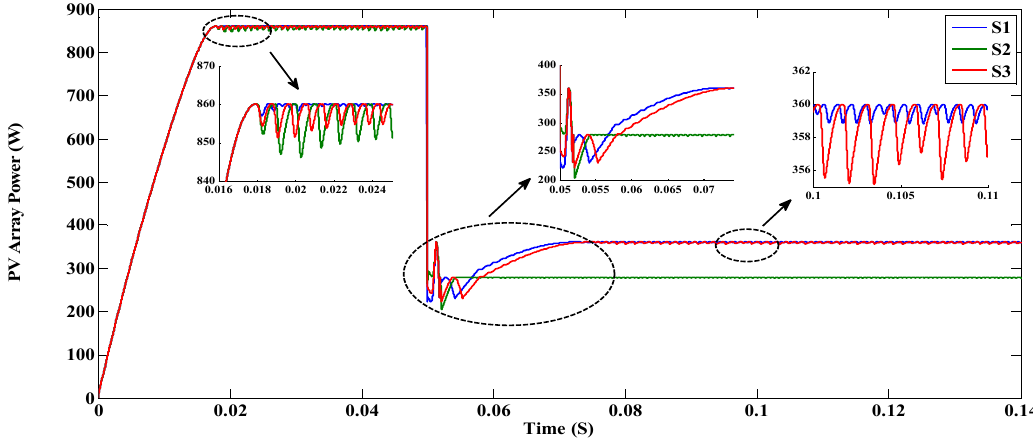
Figure 13. PV output powers for the scenario of Figure 12a.